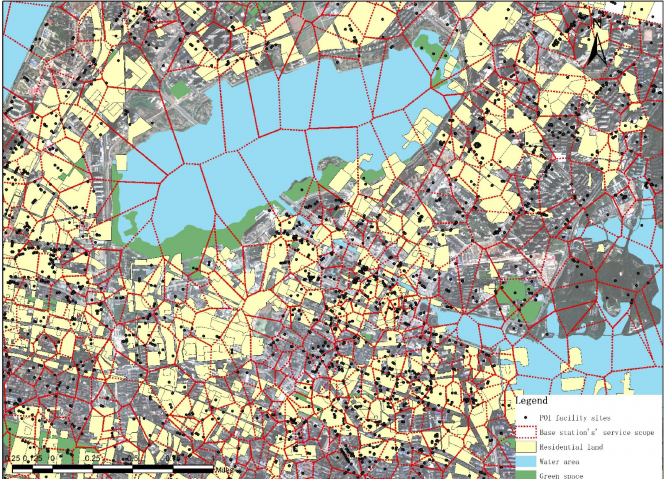
Figure 6. Schematic illustration of the relationship between base stations and POI